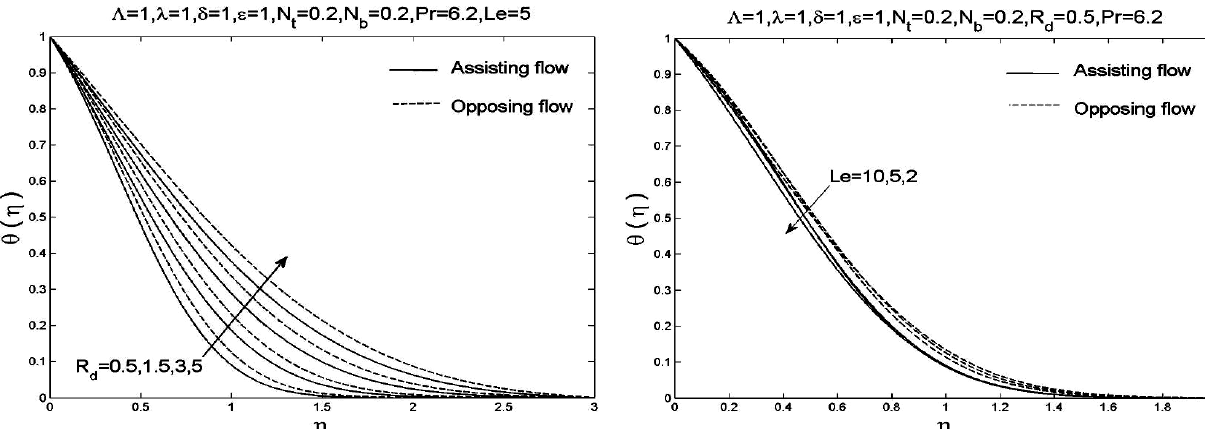
Fig. 17. The effect of the radiation parameter on the temperature profiles ( ) θη .